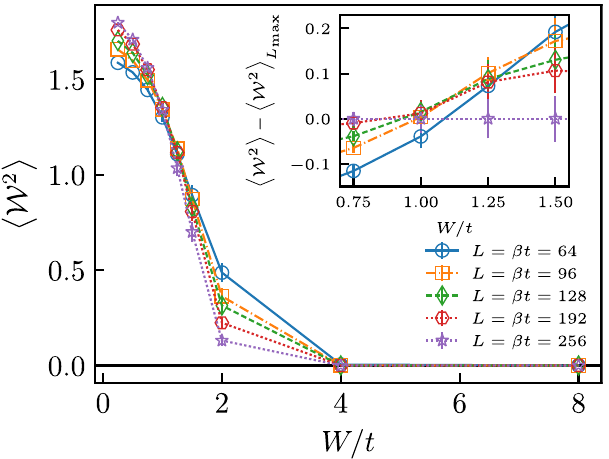
Fig. 1 Mean-square winding numbers. h W 2 i as a function of the disorder strength W for lattice sizes L = 64 (blue circles), 96 (orange squares), 128 (green diamonds), 192 (red hexagons), 256 (purple stars). Inset highlights the area near the phase transition, showing crossing points between the curves within the interval W c = 1.00 ± 0.15; the curve corresponding to the largest size ( L = 256) is subtracted from all data for clarity. Vertical error bars indicate the estimated uncertainty from the Monte Carlo simulations and